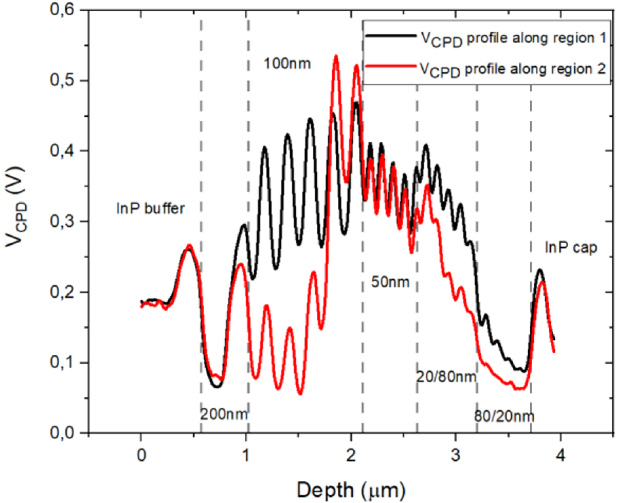
Fig. 4. Vertical pro fi les of the two regions labeled with 1 and 2 identi fi ed in the V CPD map in Figure 3b. The pro fi les correspond to the regions identi fi ed by the two dotted white segments, and they were obtained by averaging over a width of 128